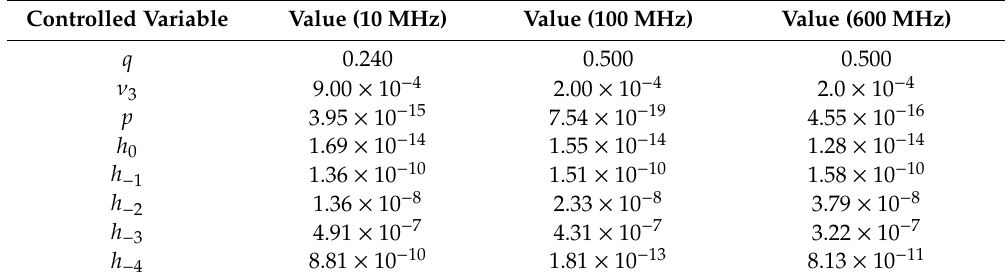
Table 2. The controlled variables extracted by the best fitting of power spectral density